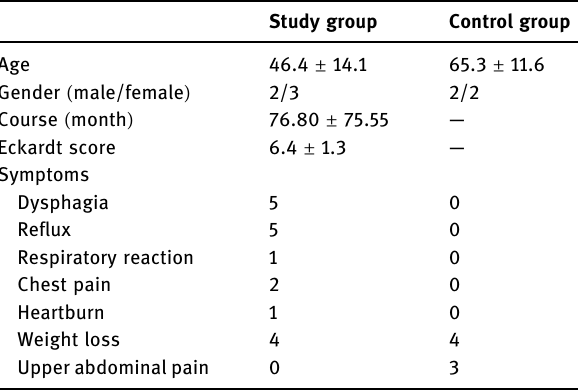
Table 1: Clinical characteristics of patients and